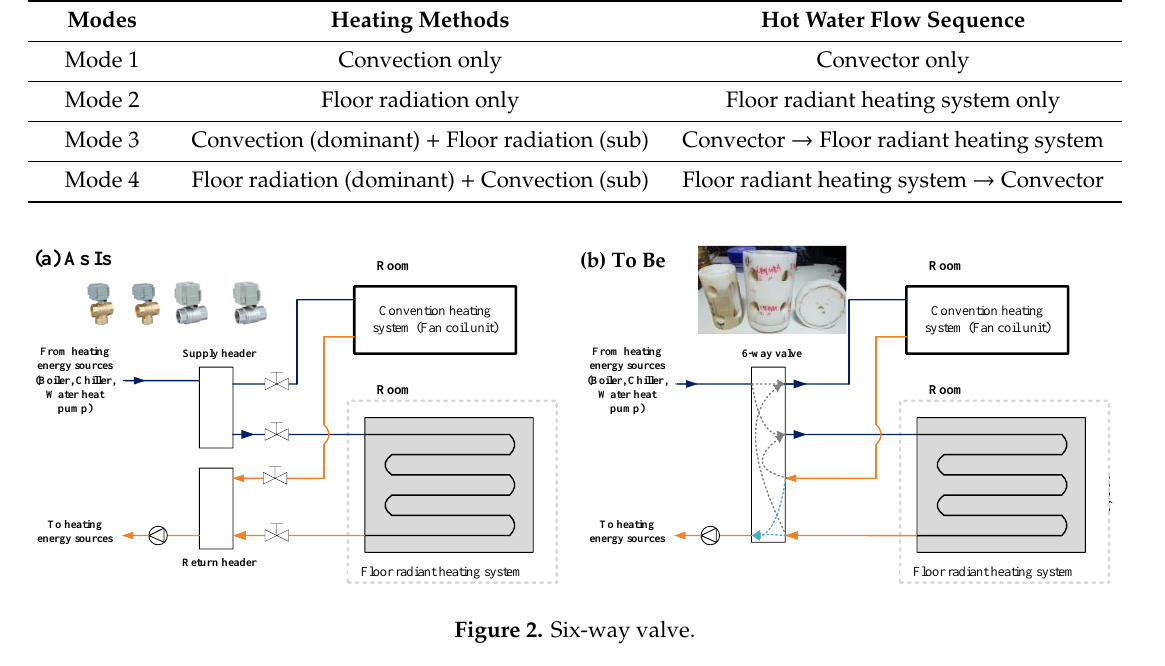
Table 1. System operation modes.